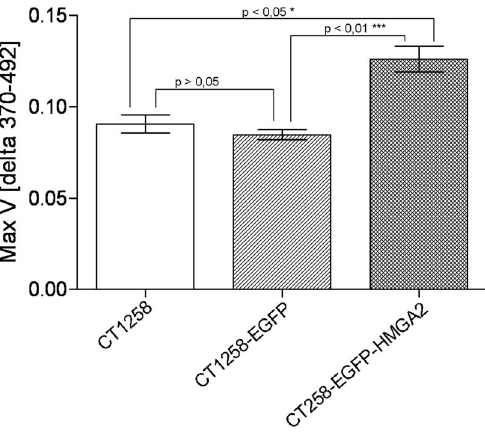
Figure 6. BrdU cell proliferation assay. Measured proliferation of native CT1258, CT1258-EGFP and CT1258-HMGA2-EGFP cells. A statistical significant increased proliferation was detected for CT1258 cells expressing the EGFP-HMGA2 fusion protein in comparison to native CT1258 and EGFP expressing CT1258 cells. Each bar represents a mean 6 SD, *p # 0.05, ***p # 0.001.